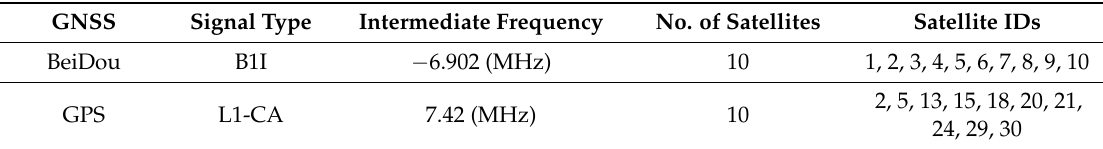
Table 3. GNSS signal information for open sky scenario.